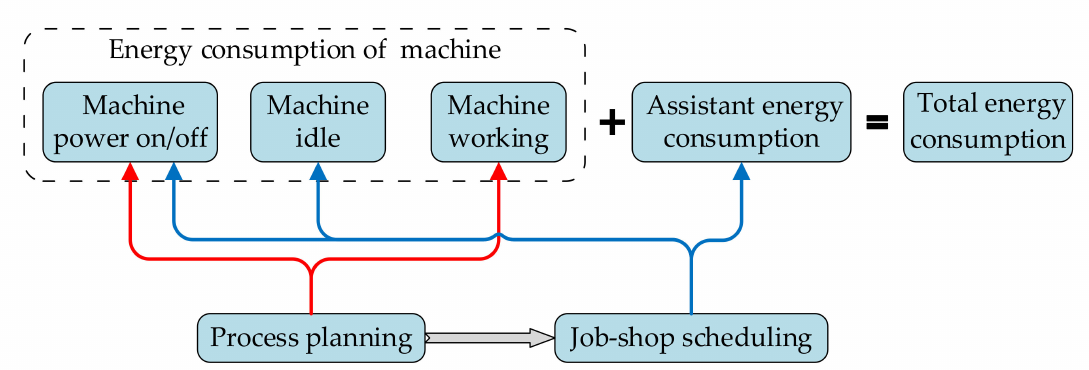
Figure 2. The influence relationship used for process planning and job shop scheduling of the energy consumption involved in the manufacturing